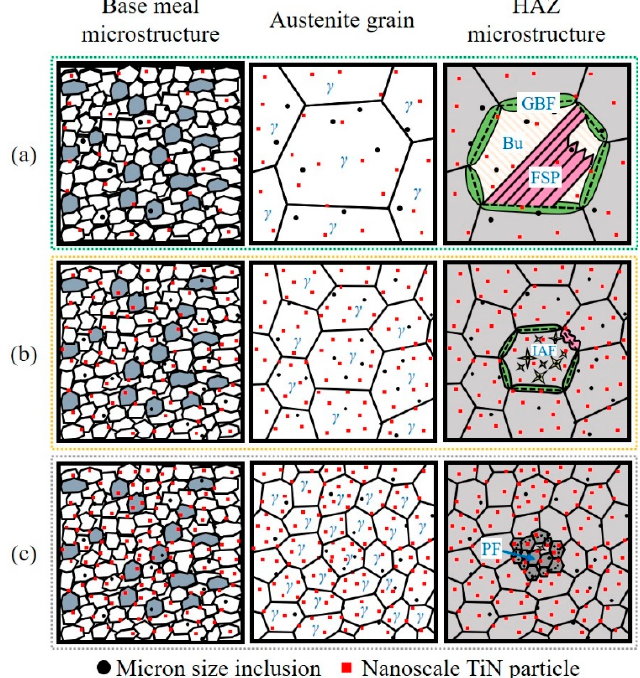
Figure 13. Schematic diagram of the mechanism for improving the HAZ toughness by inclusion control with Mg deoxidation: ( a ) A, ( b ) LM, and ( c ) HM.